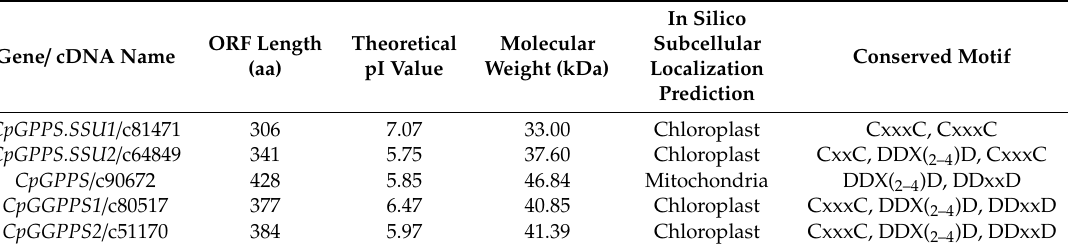
Table 1. Characteristics of Cp GPPS / GGPPS